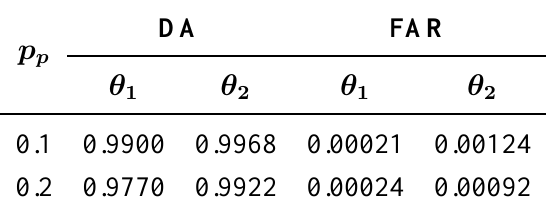
and θ for p = 0.2, w = 4, q = 3, 1 2 t